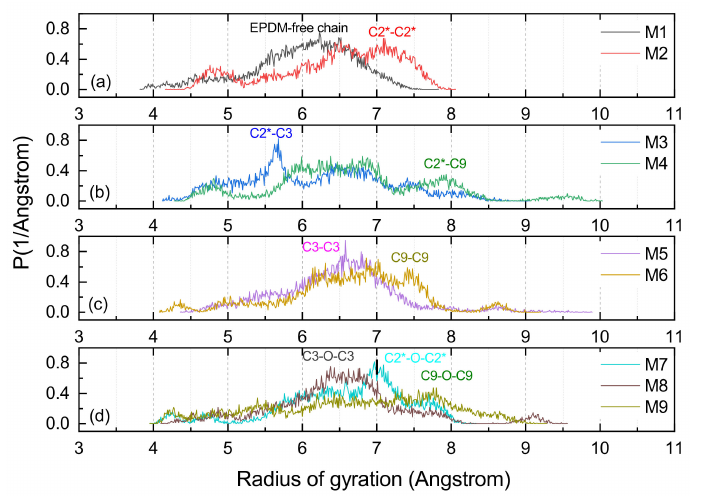
Figure 11. The Rg distribution of varied cross-linking EPDM MD models. ( a ) shows the results for M1 and M2, ( b ) is for M3 and M4, ( c ) is for M5 and M6, ( d ) is for M7, M8, and